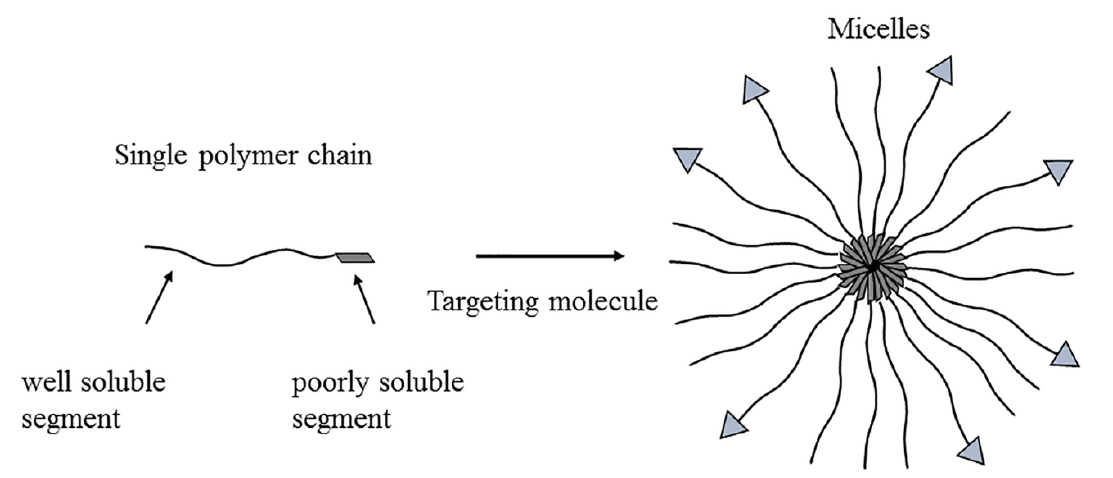
Figure 8. Illustration of copolymer micelle formation.